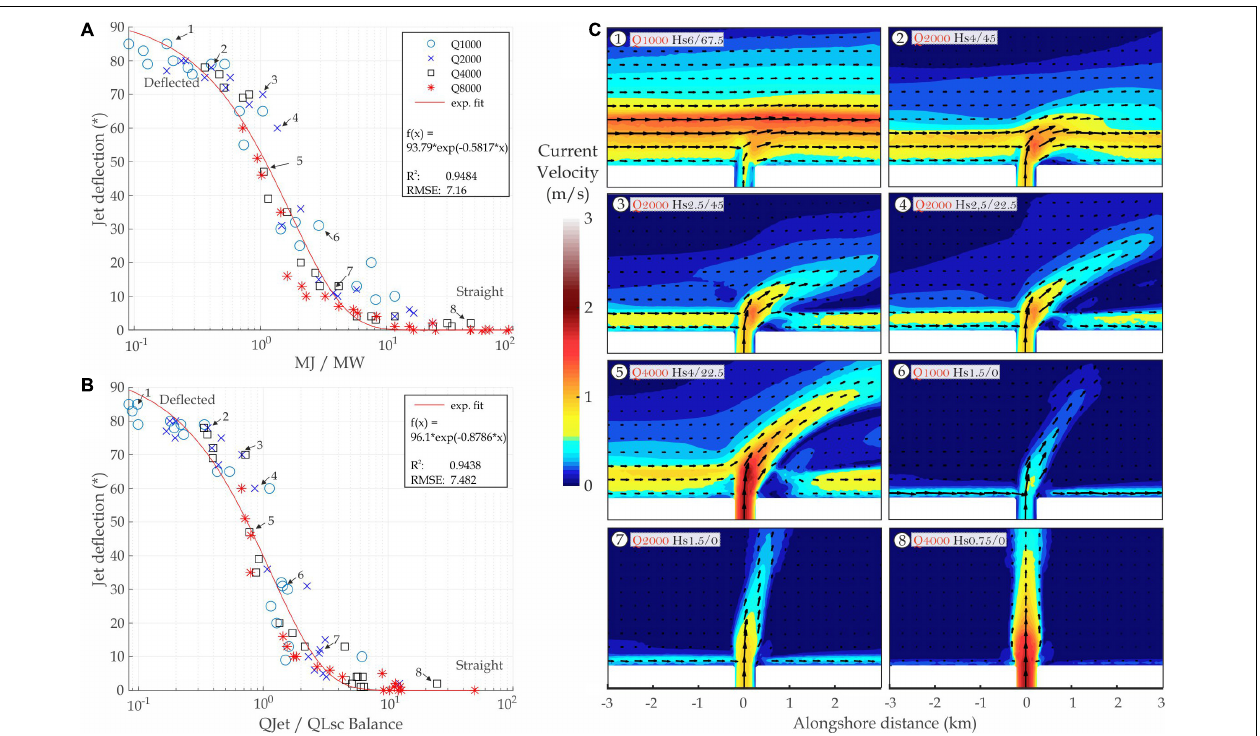
FIGURE 5 | River jet and wave-driven LSC interactions in the No RMB case. The jet deflection angle is plotted against the momentum of jet to the momentum of waves ratio ( MJ / MW ) (A) , or against the balance of jet discharge ( Q Jet ) and LSC discharge ( Q LSC ) (B) . A selection of river jets is shown in (C) which illustrate the change in jet orientation from deflected to straight. A total of 90 ◦ directions are excluded because these produce only jet spreading. Conditions for each simulation are shown in the upper left corner of each panel ( Q1000 is 1000 m 3 /s discharge and 1.5/45 denotes 1.5 m Hs , 45 ◦